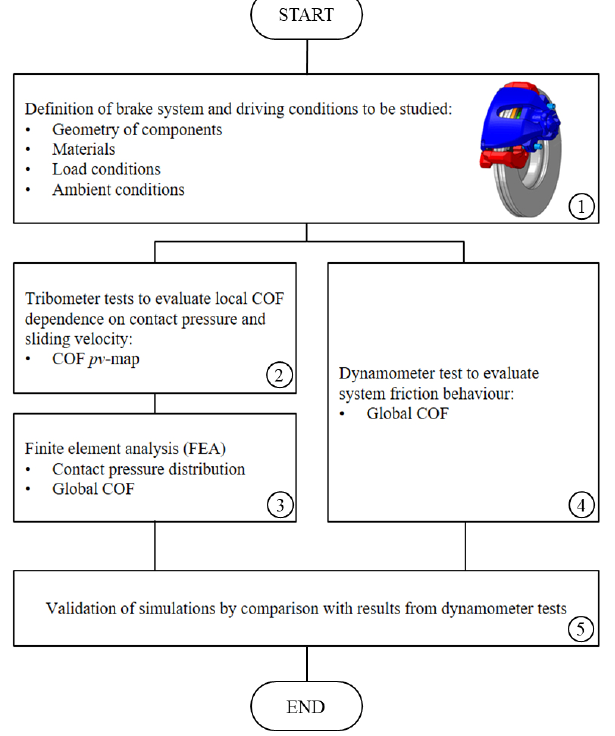
Fig. 1 An overview of the simulation methodology.